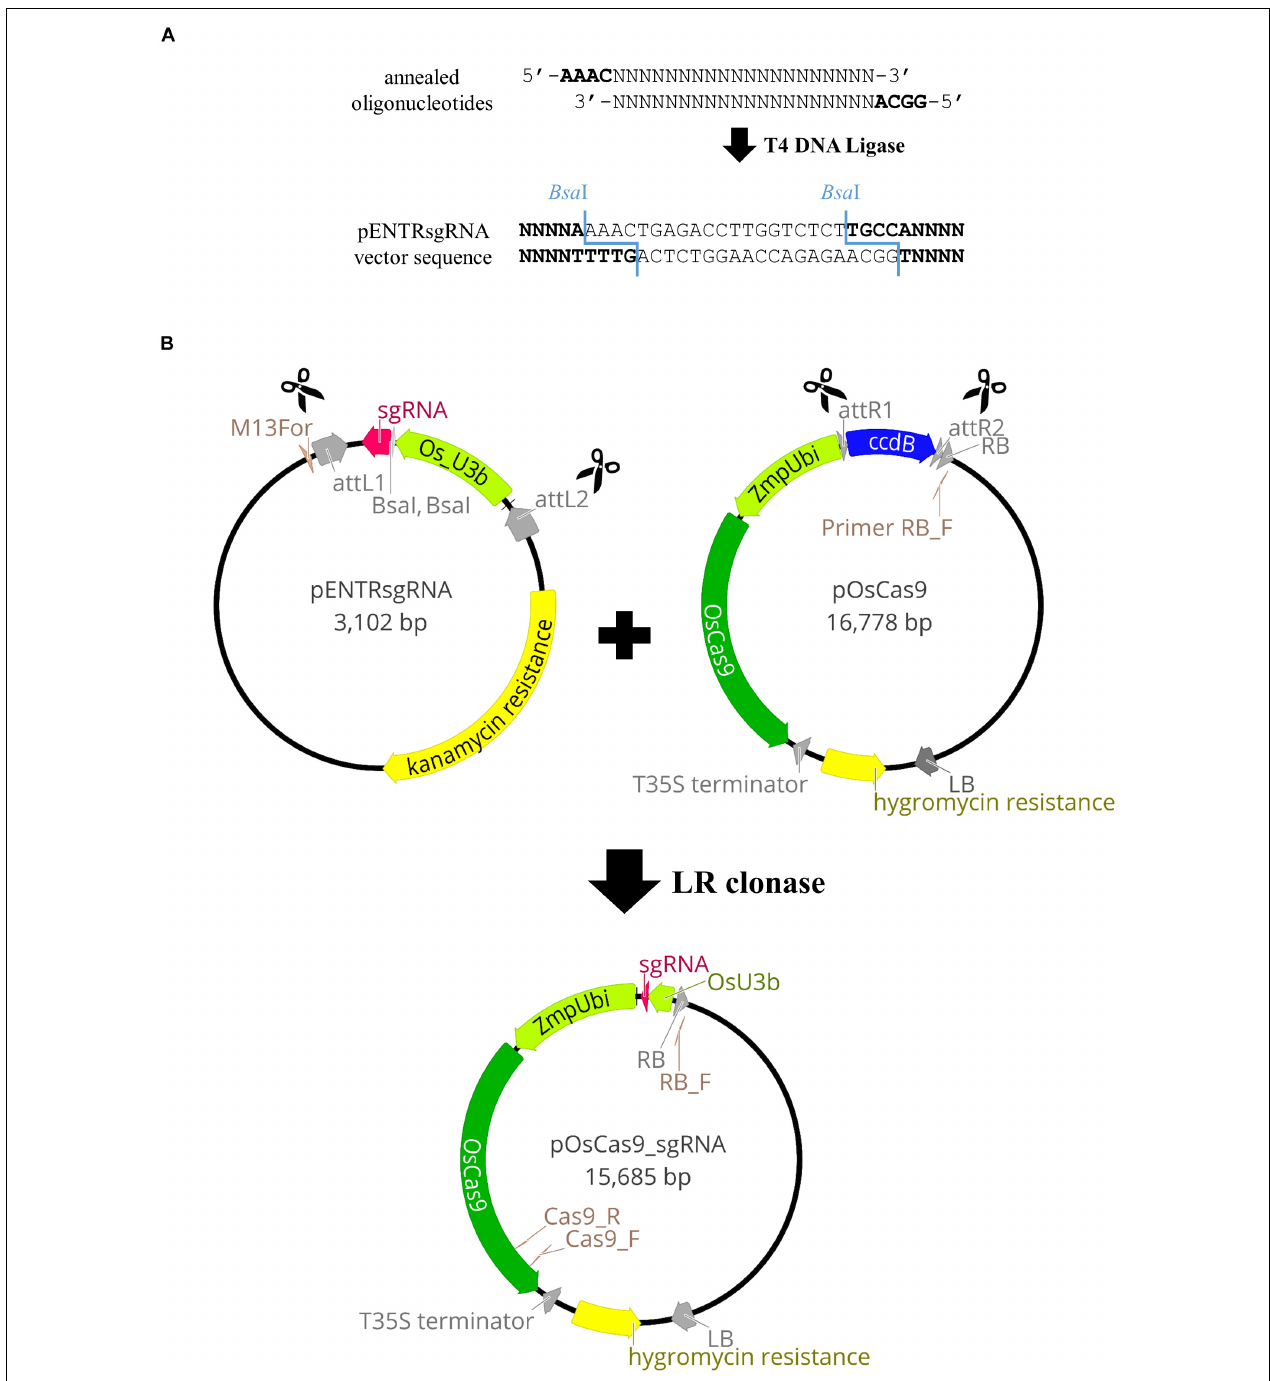
FIGURE 2 | Schematic illustration of the pOsCas9_sgRNA vector construction. (A) Cloning of the gRNA sequence into pENTRsgRNA vector. (B) Diagrams of the plasmids used for targeted mutagenesis of Brachypodium species and the scheme of the LR recombination reaction.